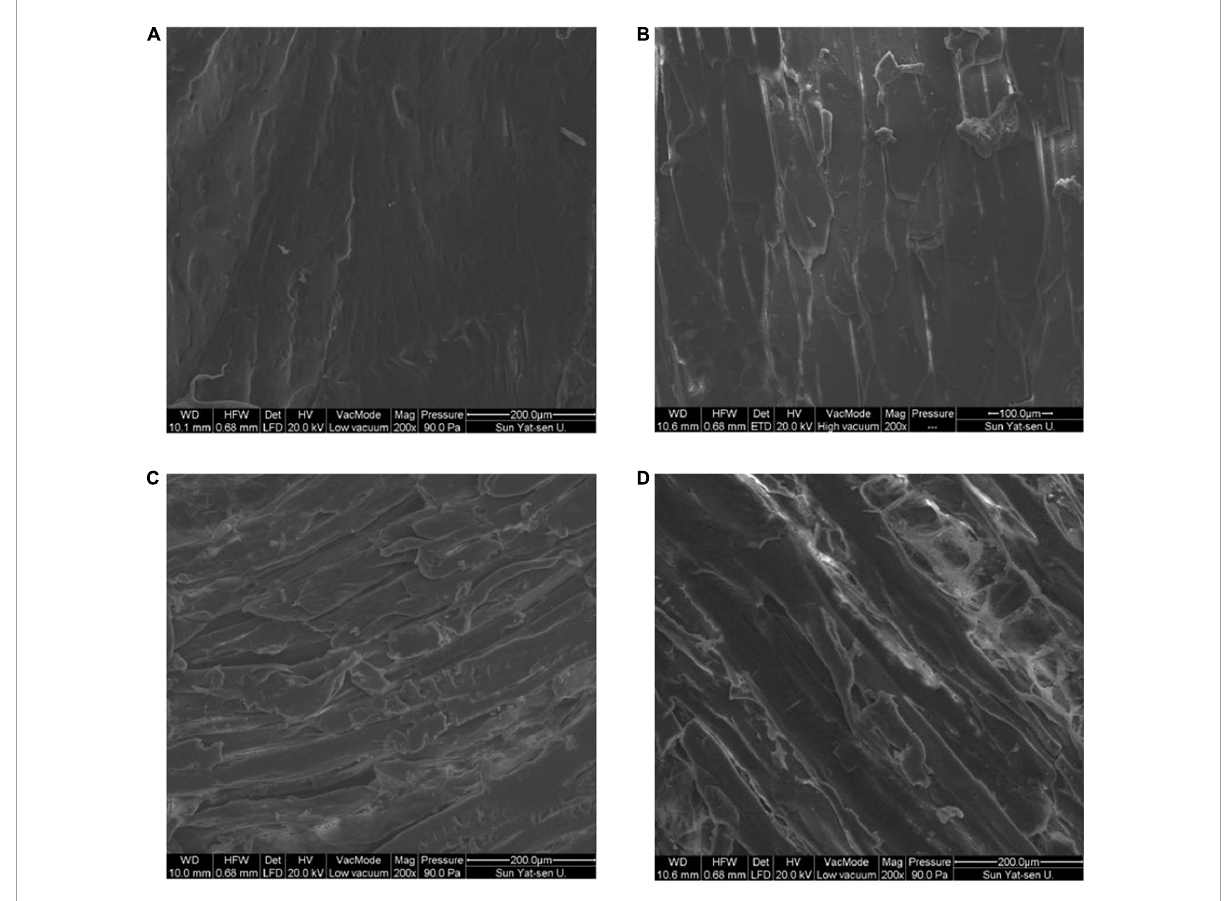
FIGURE2 Effect of different drying methods on the tissue microstructure of fish filets. (A) Fresh sample; (B) hot air dried sample; (C) heat pump dried sample; (D) freeze dried